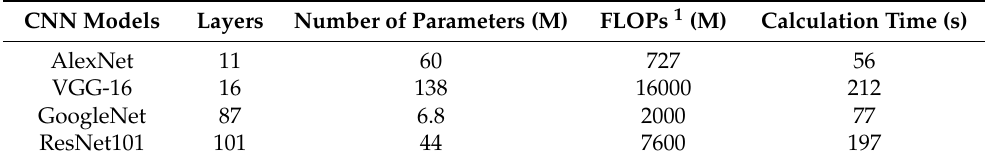
Table 4. Comparison of the calculation efficiency of different CNN models. CNN Models